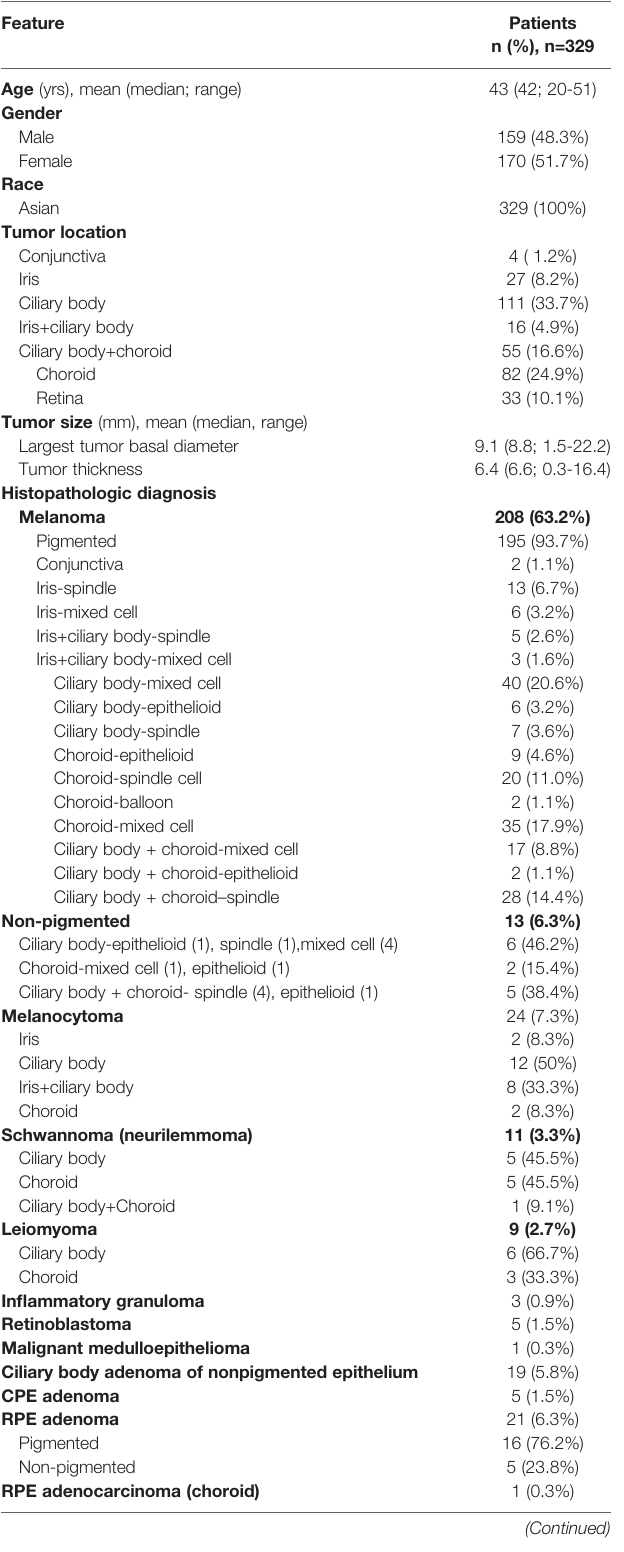
TABLE 1B | Surgical Resection (Partial Transscleral Sclerouvectomy Combine with Mircoinvasive Vitrectomy and Reconstruction of the Eyeball) of Intraocular Tumors in 329 Adult: Demographic and Clinical Features.